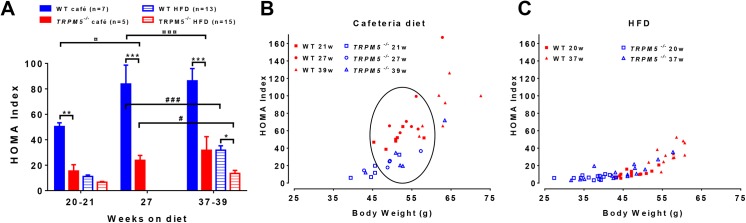
Effects of diet on basal insulin and glucose levels in female Trpm5
-/- and wild type mice.Baseline glucose and insulin levels were recorded after a 4h fasting at different time points (weeks) after start on diet. (A) The group HOMA index was calculated. Individual HOMA index were then related to individual bodyweight for cafeteria diet (B) and HFD (C). The circle emphasize where Trpm5
-/- and wild type mice have similar body weight, but Trpm5
-/- have a reduced HOMA:IR vs wild type. Data are presented as mean ± SEM, **p<0.01, ***p<0.001 Trpm5
-/- vs wild type at corresponding age and diet, ¤p<0.05, ¤¤¤p<0.001,Trpm5
-/- vs wild type at corresponding bodyweight and diet, #p<0.05, ###p<0.001 cafeteria diet vs HFD for respective genotype (ANOVA with Bonferroni post-hoc test).